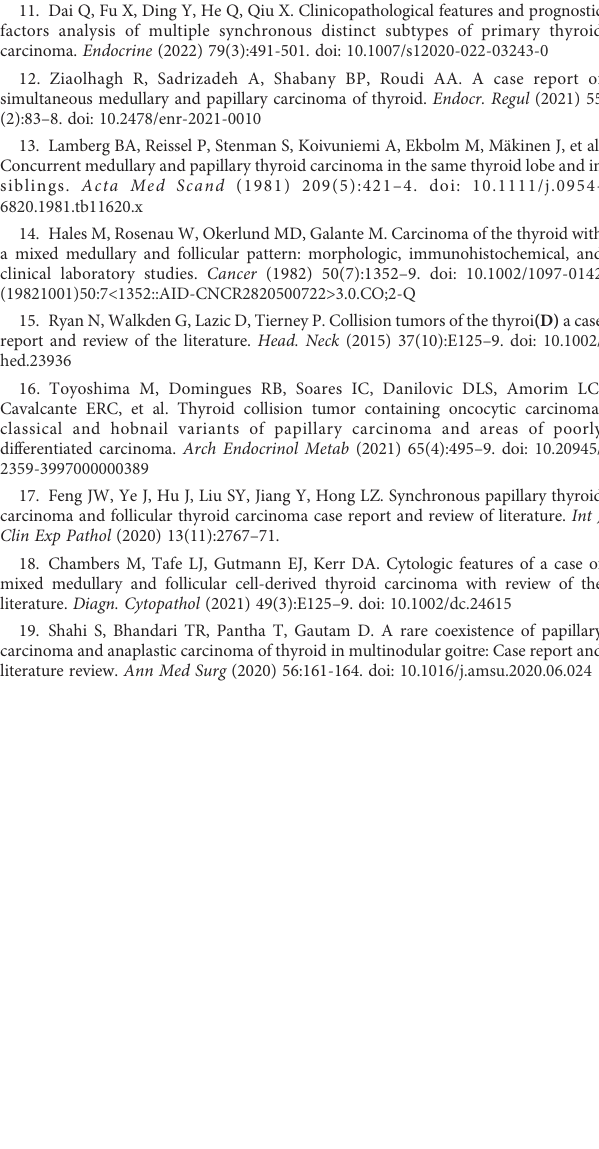
SUPPLEMENTARY FIGURE 3 Immunohistochemistry of patient n.26 that MTC and PTC were located in the different thyroid lobe respectively. (A) CD56(+); (B) CgA(+); (C) CT(+); (D) Galectin3(+); (E) Ggh(+); (F) Syn(+); (G) Tg(+); (H) TTF-1(+). SUPPLEMENTARY TABLE 1 Lymph node metastasis of 15